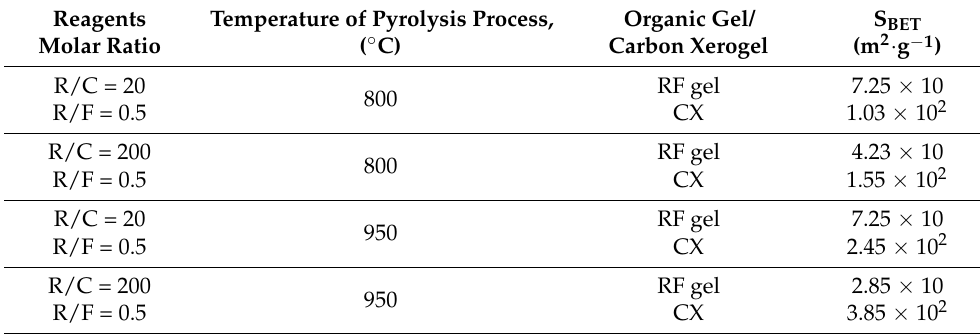
Table 1. Synthesis parameters for RF carbon xerogels.